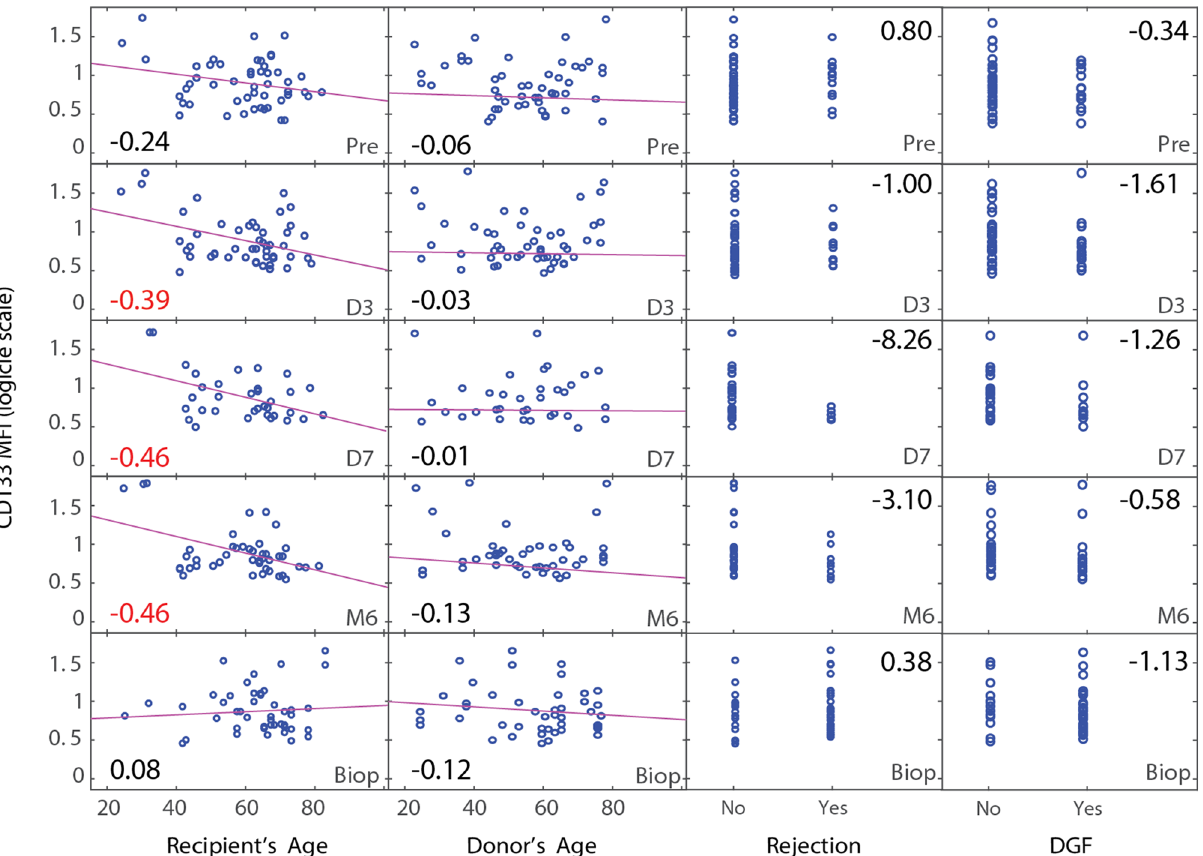
Figure 3. Expression of CD133 in cEC of kidney transplant patients. Correlations between recipient and donor age, and CD133 MFI expression in cEC before and after transplantation. The displayed Pearson’s linear correlation coefficients indicate the slopes of the least-squares reference lines in the scatter plots. The two columns on the right show the logistic regression between CD133 in cEC and rejection and DGF. Patients with DGF were such patients who needed renal replacement therapy within the first seven days after transplantation. The displayed logistic coefficients indicate the change in the log odds of having a rejection. Coefficients marked in red are significant (p <